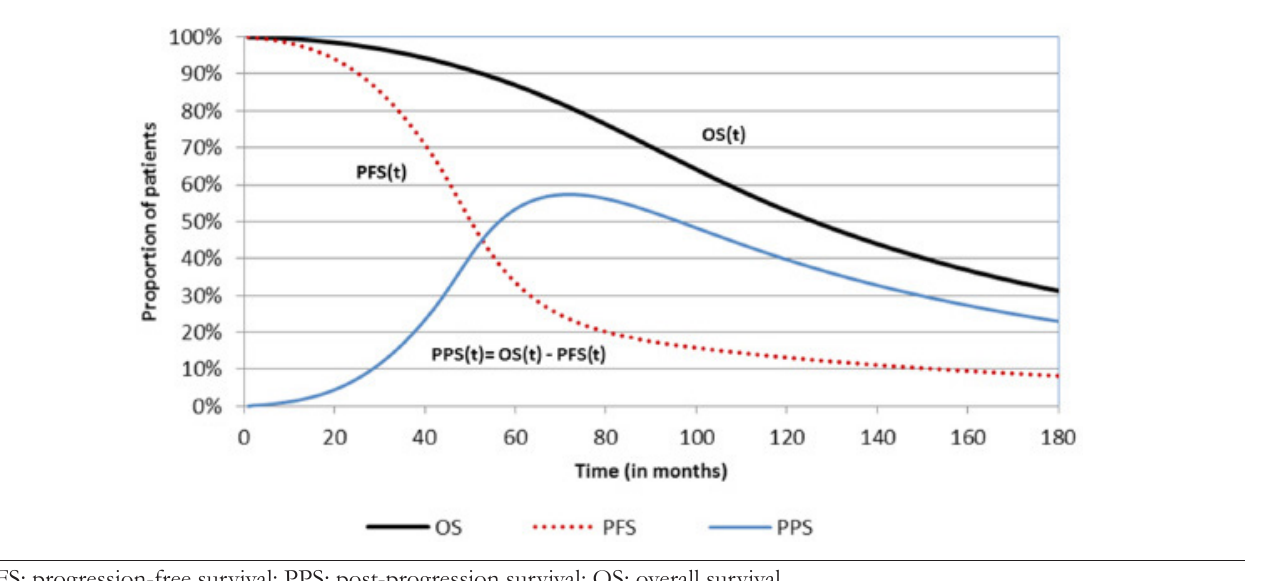
Figure 1. Survival curves based on PFS and OS data to track state occupancy